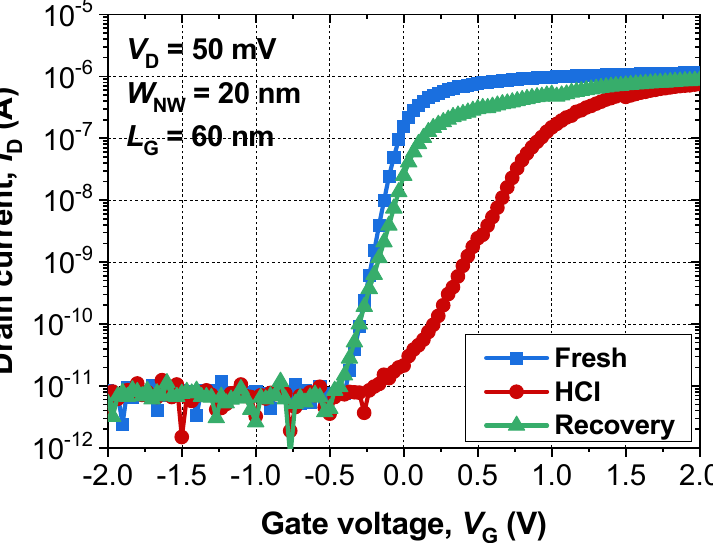
Figure 3. Measured I D ‐ V G characteristic of the fabricated n ‐ channel GAA FET. Table 2. Bias conditions for punch ‐ through current based